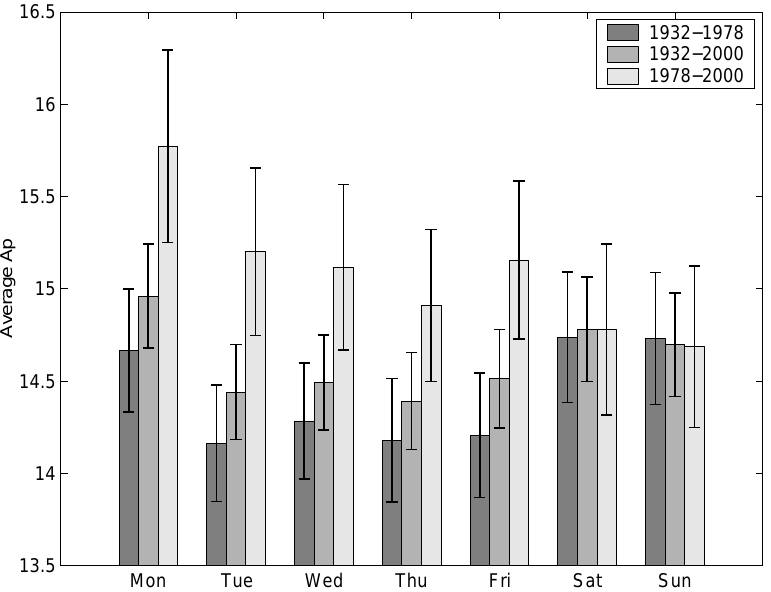
Fig. 1. Mean values and standard errors of the A p index for each day of the week in 1932–1978, 1932–2000 and 1978–2000.